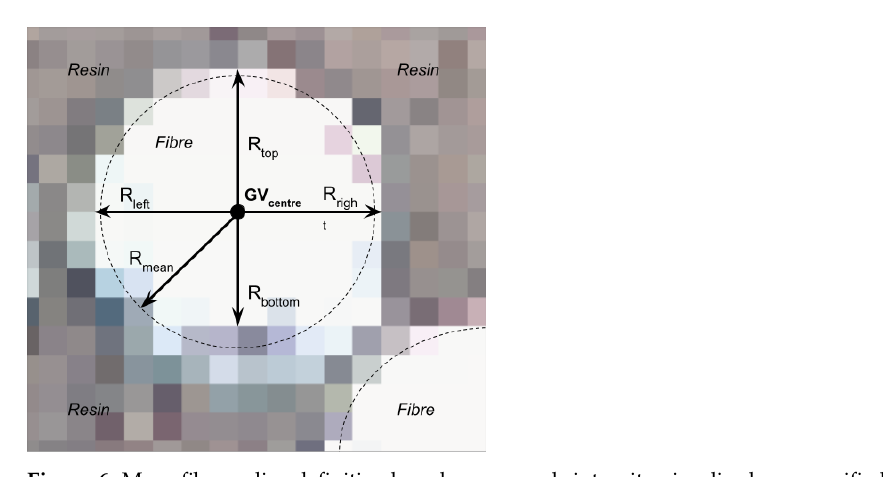
Figure 5. Flow diagram describing the procedure to determine fibre radii based on greyscale values.